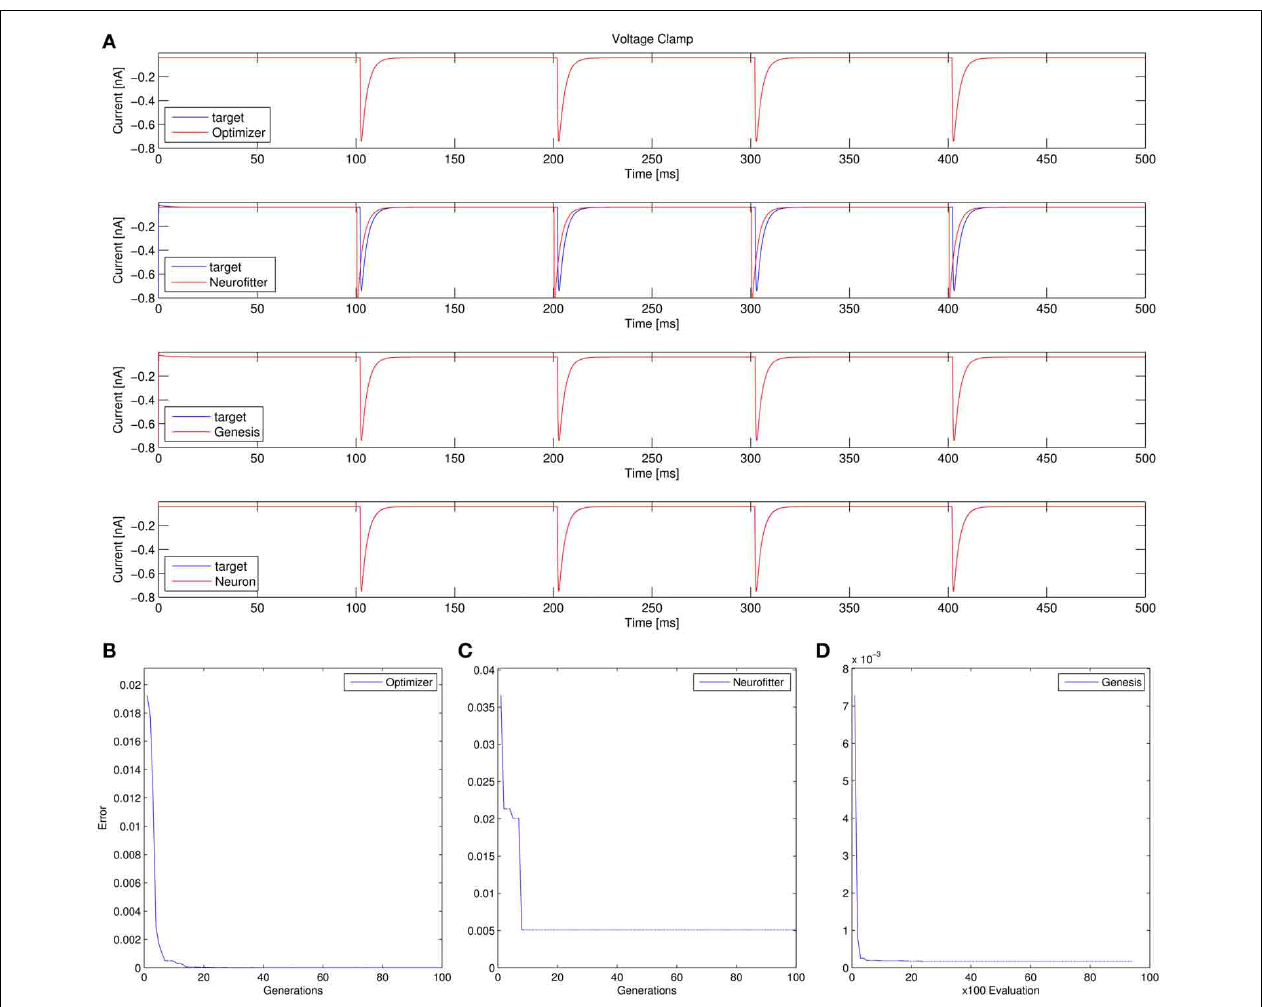
FIGURE 10 | Comparison of the performance of the four model fitting tools on Use case 2 (fitting synaptic parameters in voltage clamp). Figure layout and notation are similar to Figure 9 . Error values